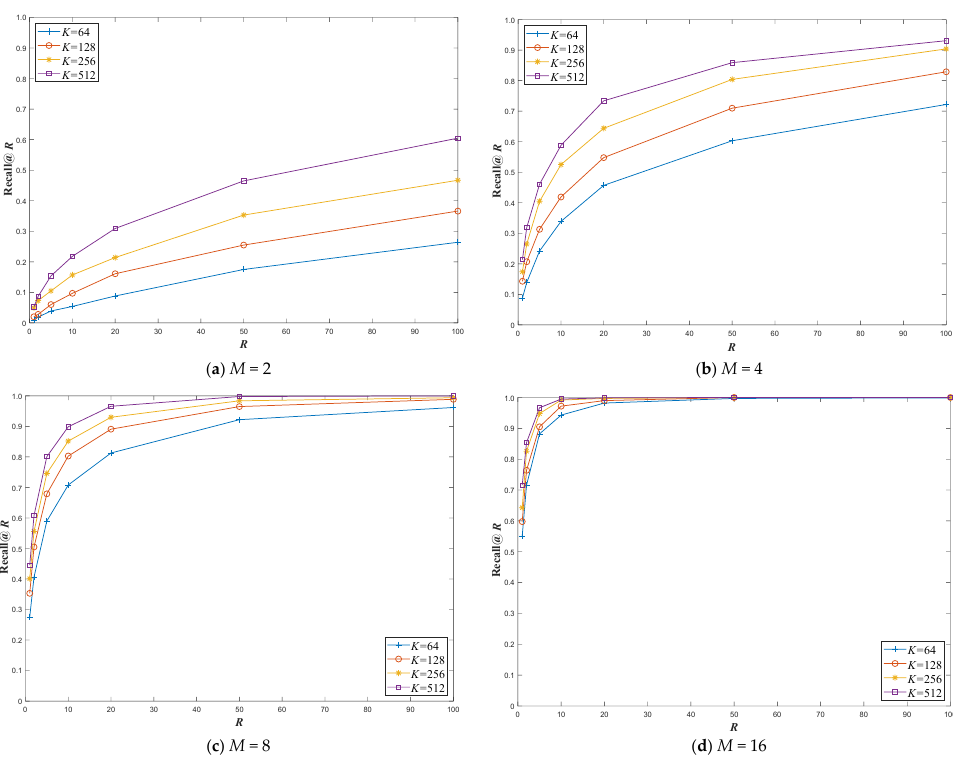
Figure 6. The quantization errors on 1M database vectors under different K and M.